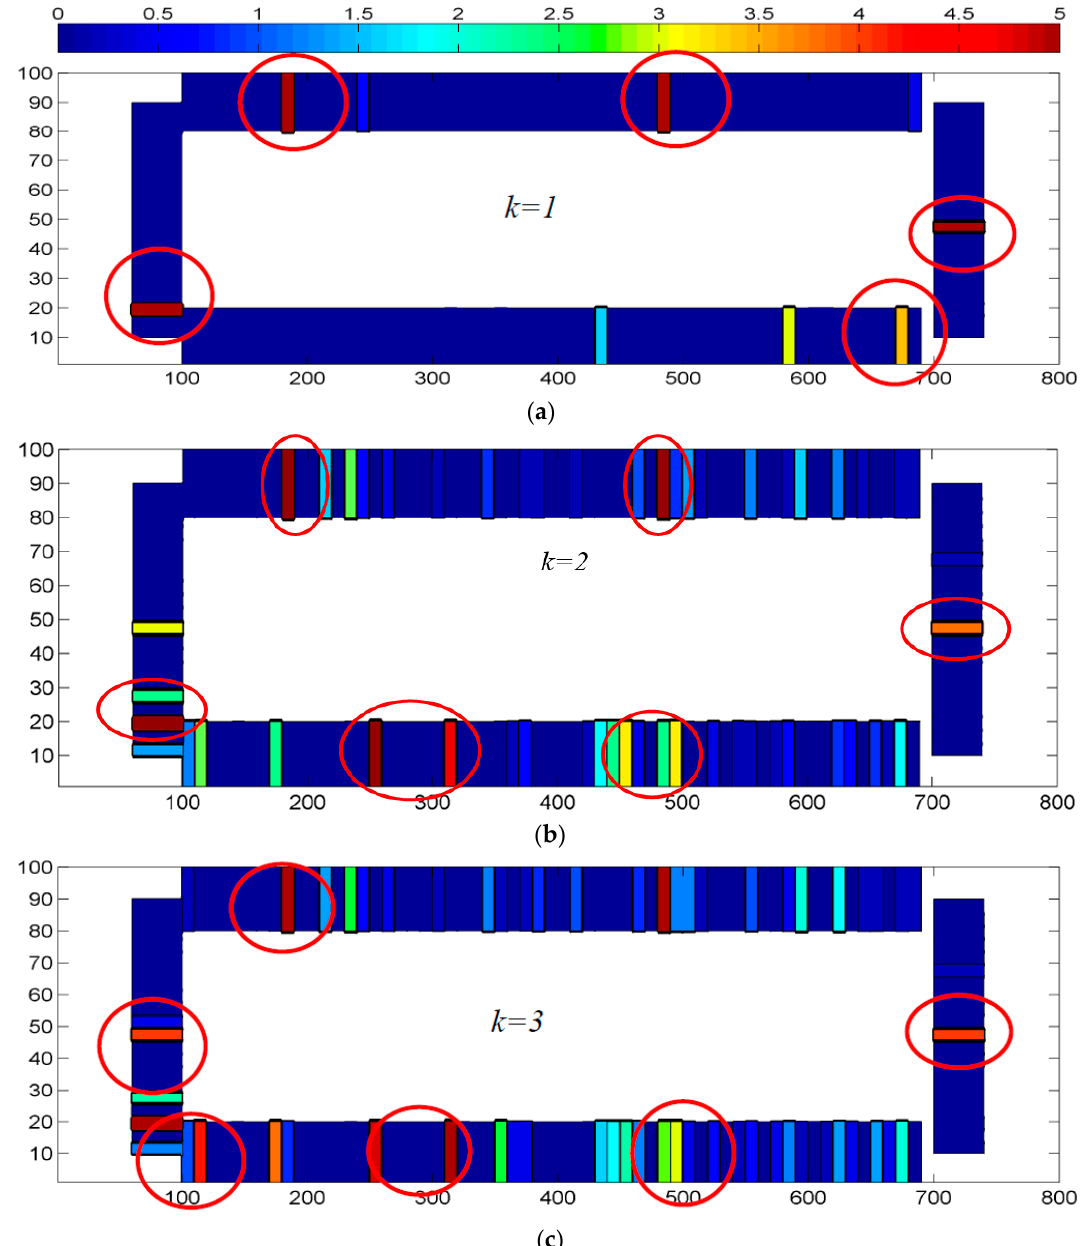
Figure 13. Accuracy of localization by using WkNN for different numbers of neighboring points. ( a ) k = 1; ( b ) k = 2; ( c ) k = 3.